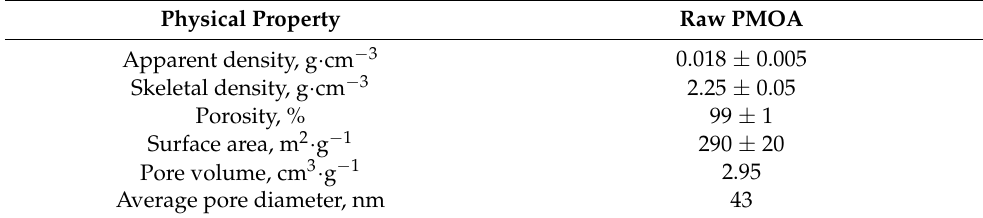
Table 1. The physical properties of raw PMOA samples